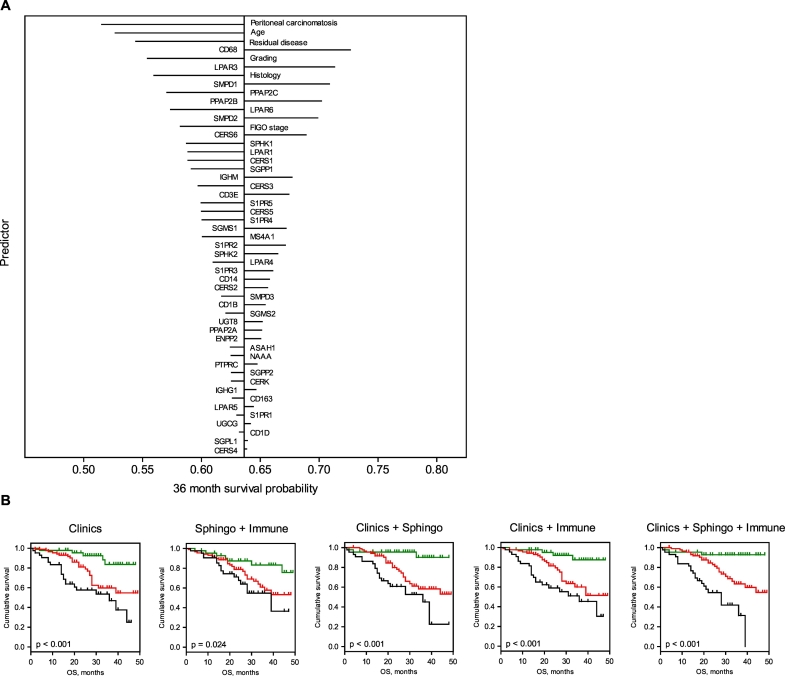
Multivariable prognostic models.A Impact of individual variables on survival prediction of the Clinics + Sphingo + Immune multivariable model (ridge) for OS if predictors are changed by +1 SD. Survival probabilities are estimated at 36 months of follow-up time. Variables are ranked according to the absolute changes in prediction. The length of the lines is proportional to the change in prediction in case the value of the indicated variable changes by +1 SD (left: negative effect; right: positive effect).B Kaplan-Meier estimates for patient stratification based on the multivariable models (ridge) for OS. Kaplan-Meier curves for OS are shown giving patients' stratification into low risk (green), intermediate risk (red), and high risk (black) groups with the 25th and the 75th percentiles serving as thresholds (lower than the 25th percentile indicates low risk); p-value of the log-rank test is indicated. Kaplan-Meier estimates are not shown for models that were not statistically significant (Table 2). (For interpretation of the references to color in this figure legend, the reader is referred to the web version of this article.)